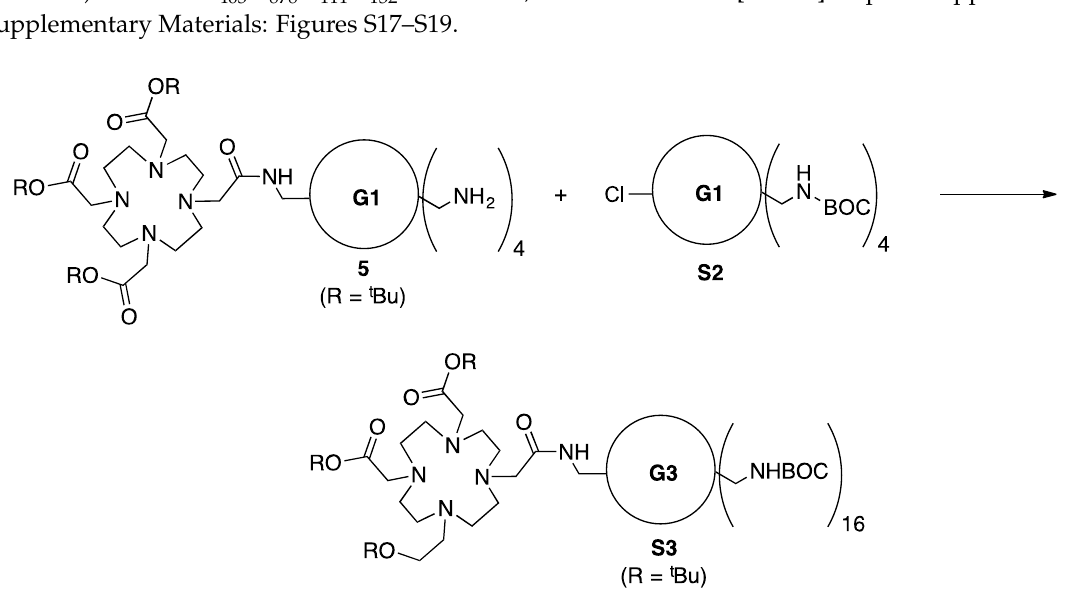
Figure 8. Intermediate 6 .